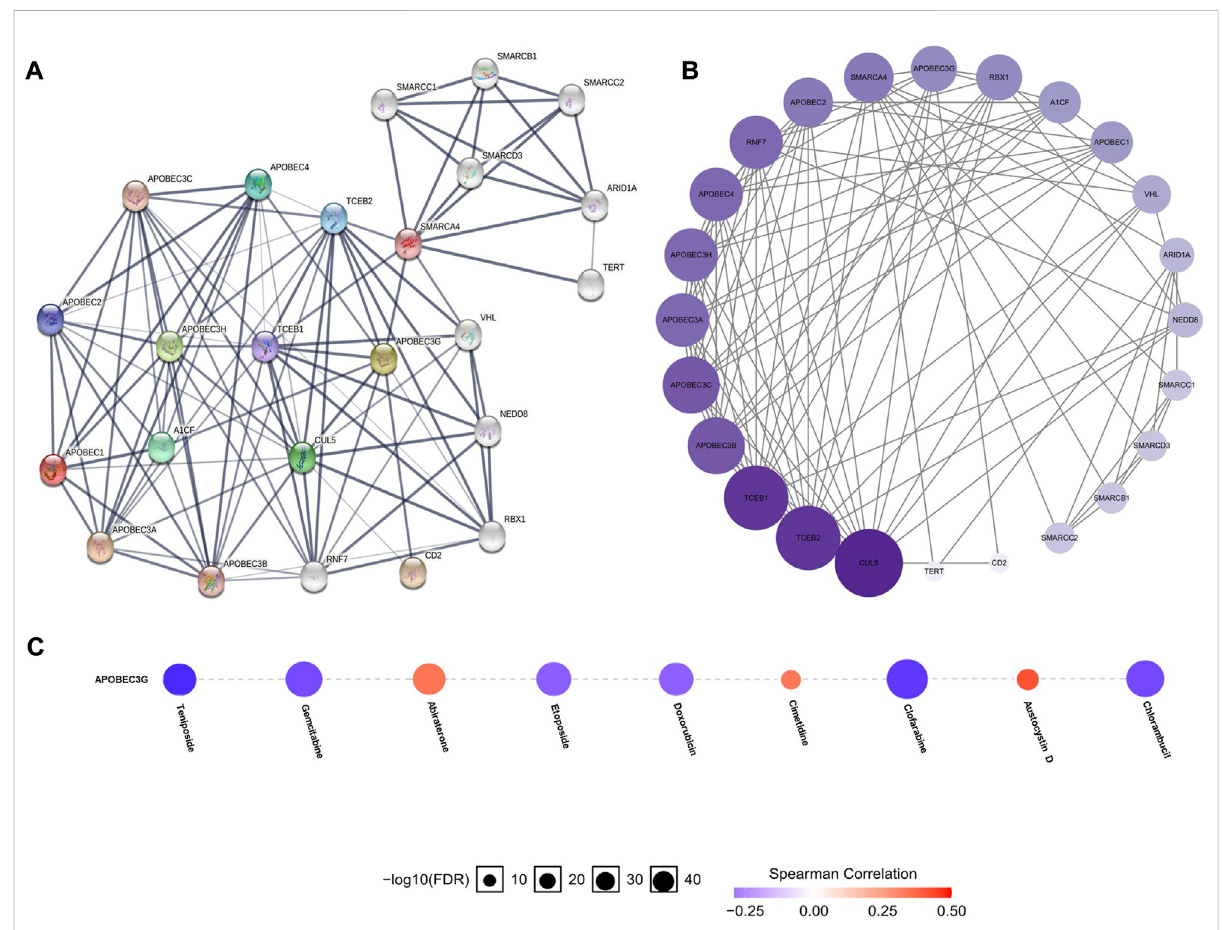
FIGURE 6 PPI network construction of the APOBEC family members APOBEC1, APOBEC3A, APOBEC3G and APOBEC3H and drug sensitivity analysis of APOBEC3G in PAAD. (A,B) SMARCA4 and CUL5 played an important role in PPI network which was closely related to APOBEC1/3A/3G/3H; (C) The expression level of APOBEC3G was positively correlated with the sensitivity of various targeted or chemotherapeutic drugs, including gemcitabine and